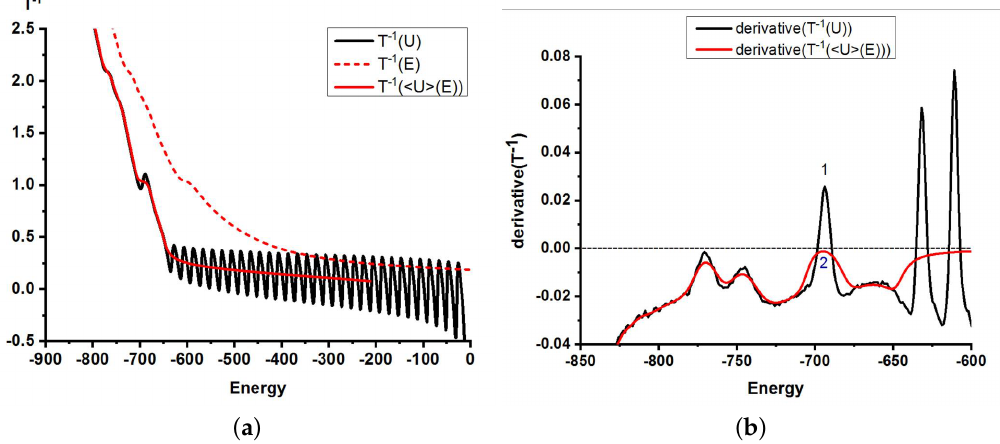
Figure 3. Results of microcanonical analysis for the case “F-attract-stronger”, b = 16, ε st = 20: ( a ) dependence of the inverse microcanonical temperature on the energy, which is either the total energy, E , or the conformational (potential) energy U , or the average conformational energy at a given value of the total energy, (cid:104) U (cid:105) ( E ) ; ( b ) first derivatives of the dependencies T − 1 ( U ) and T − 1 ( (cid:104) U (cid:105) ( E ))